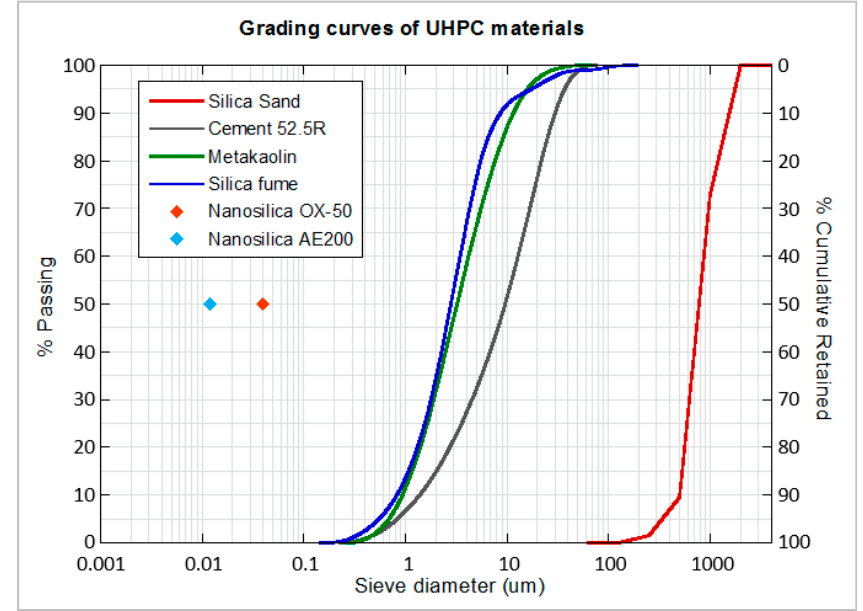
Figure 1. Grading curves of raw materials.